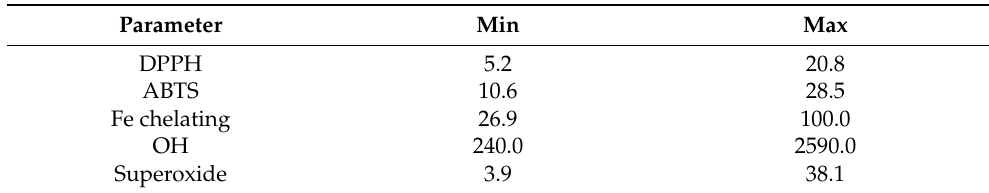
Table 2. Antioxidant activity of the HAs, IC 50 µ g/mL.